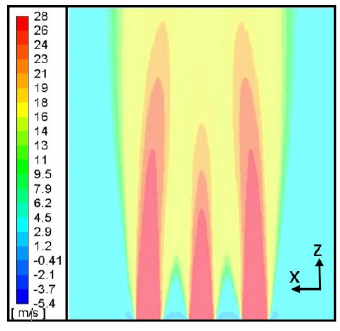
Figure 11. Axial velocity contours in the centerline plane.